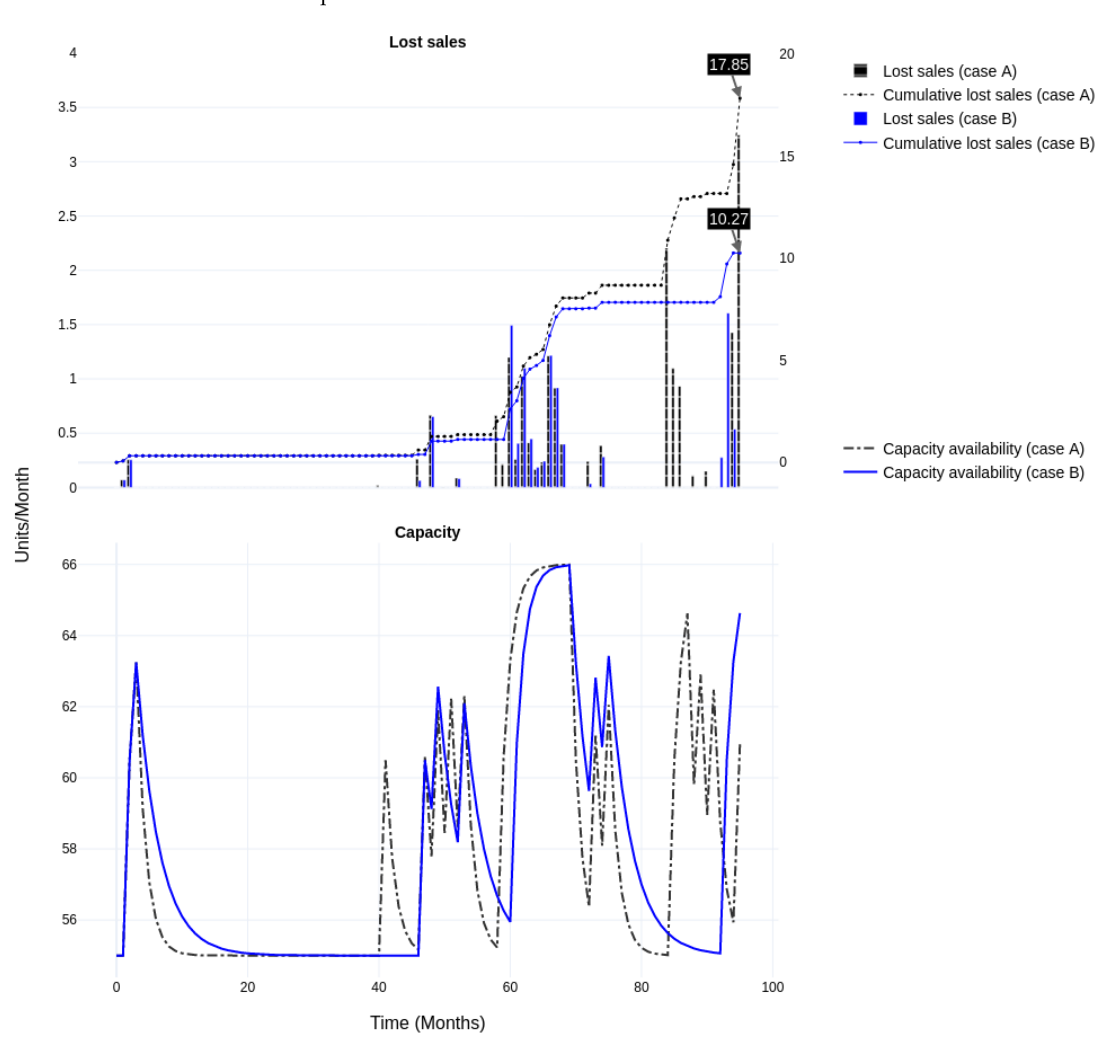
Figure 15. Comparing quick and slow ramp-down along lost sales and capacity measures.